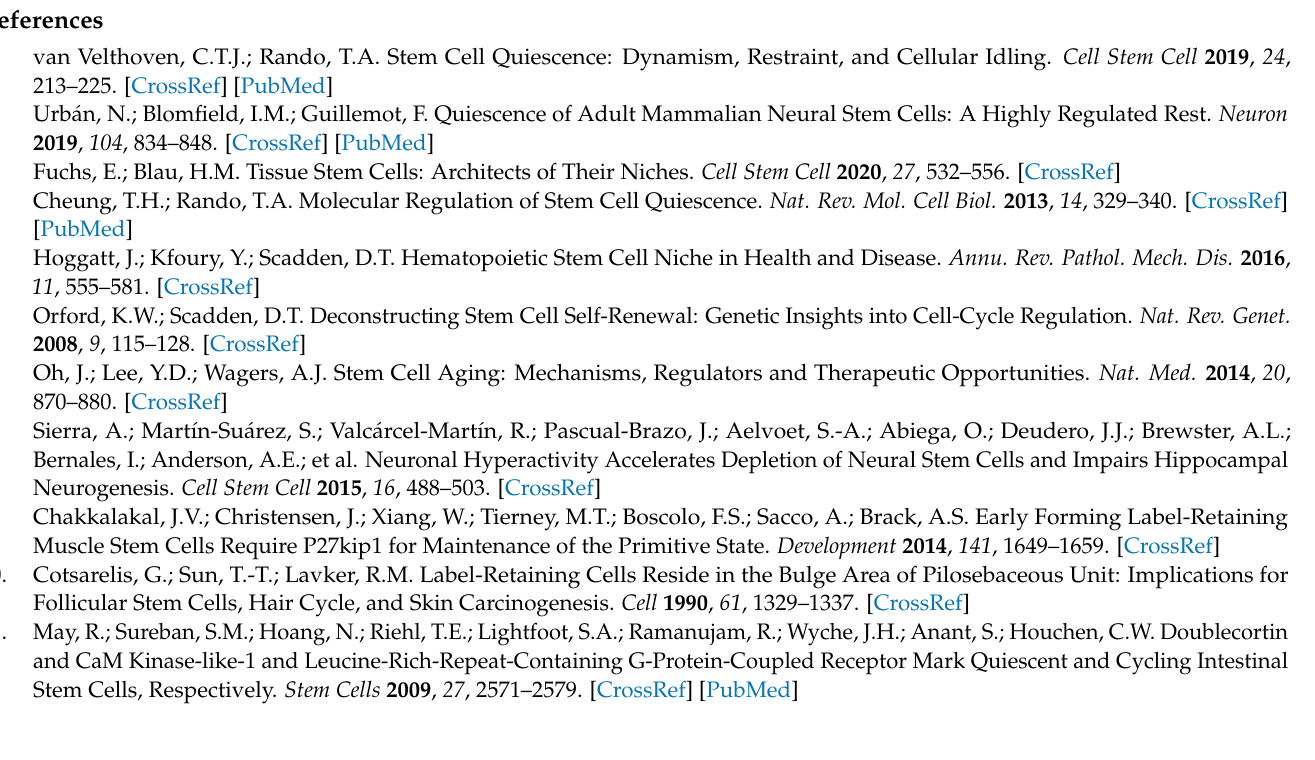
Supplementary Figure S2: Representative images of the identified phenotypes of EdU + BrdU − cells. Supplementary Table S1: Percentages of specific cell phenotypes within the EdU + BrdU −